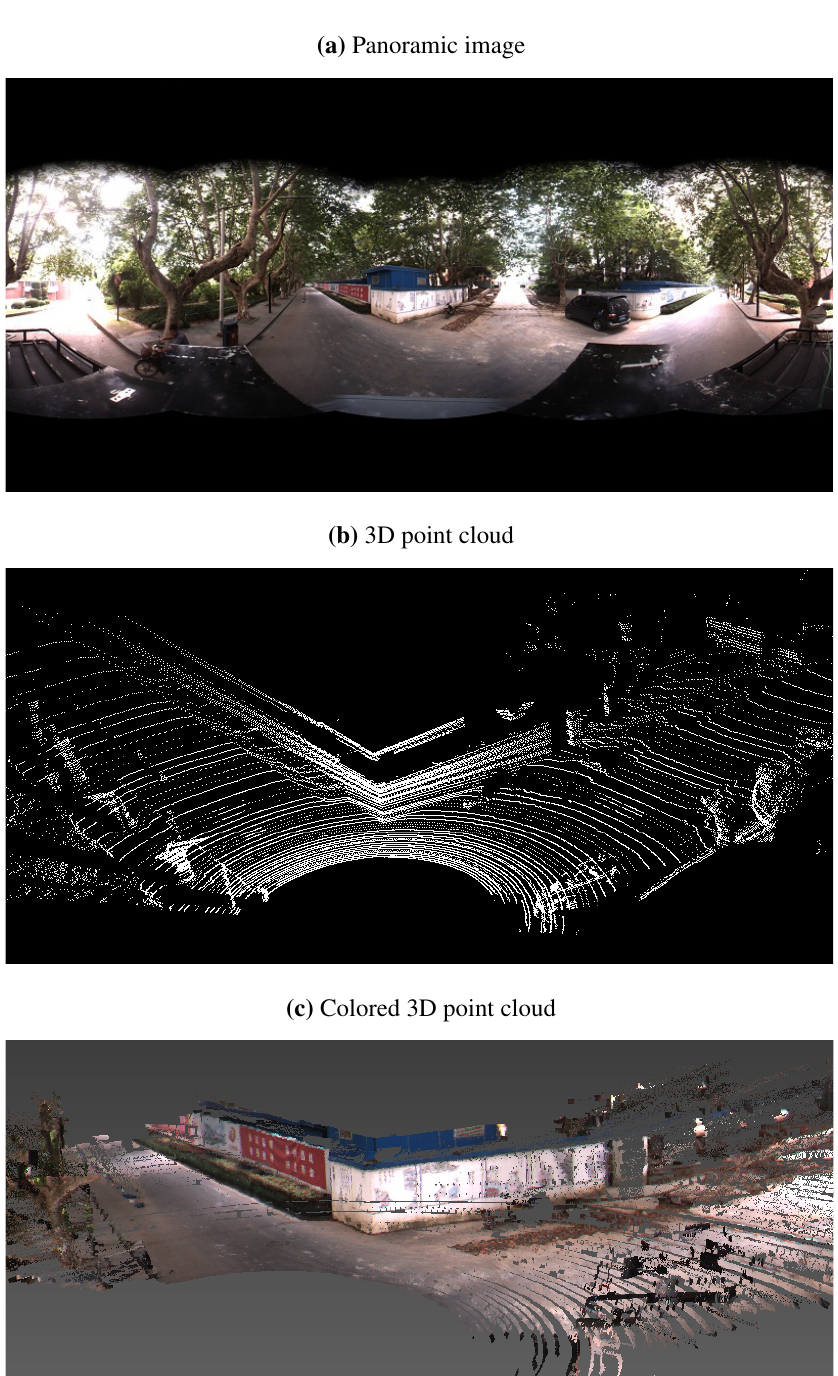
Figure 6. The first LIDAR-camera view used for calibration. ( a ) is the panoramic image captured by a Ladybug3 camera, and ( b ) is the 3D point cloud collected by a Velodyne HDL-64E LIDAR. ( c ) shows the reconstructed 3D